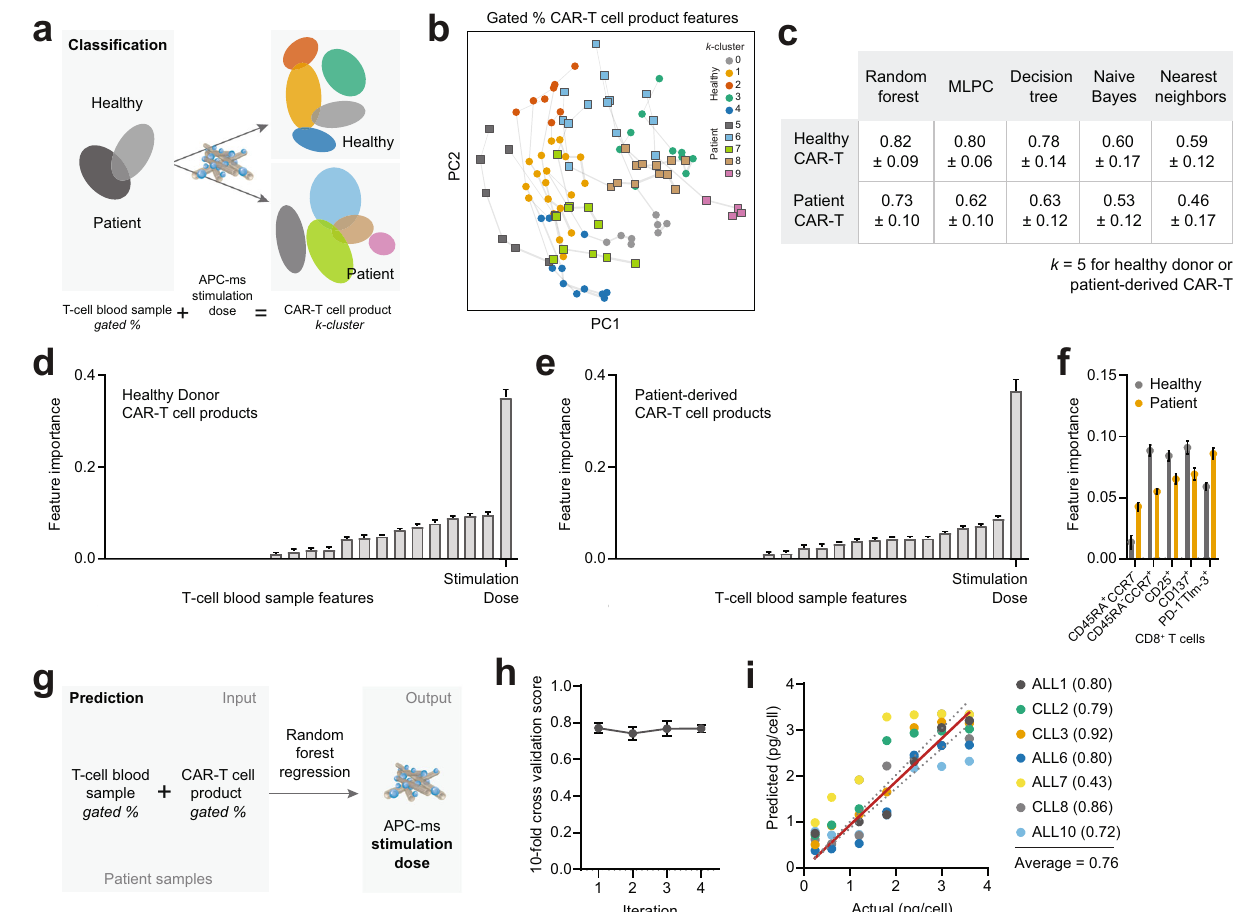
Fig. 4 | A model mapping CAR-T cell products to T-cell blood sample features and stimulation dose. a Schematic of classi fi cation model. The relationship between the phenotypeof a T-cell bloodsample, APC-ms stimulation dose, and its resulting CAR-T cell product(s) was quanti fi ed separately for healthy donor and patient-derived samples. b K -means clustering performed separately on healthy and patient-derived CAR-T cell products. The number of k- clusters was set at 5. A standard12-marker FACSpaneland gating strategywereused to establish features in the T-cellblood sample (see Supplementary Fig. 1b for gating strategy). c Cross- validated prediction scores of various machine learning classi fi cation algorithms. Different classi fi ers were iteratively trained on a subset of the data to predict the CAR-Tcellproduct k -clusterbasedontheT-cellphenotypeofthebloodsampleand stimulation level — the predictions were tested on the remaining subset of data.